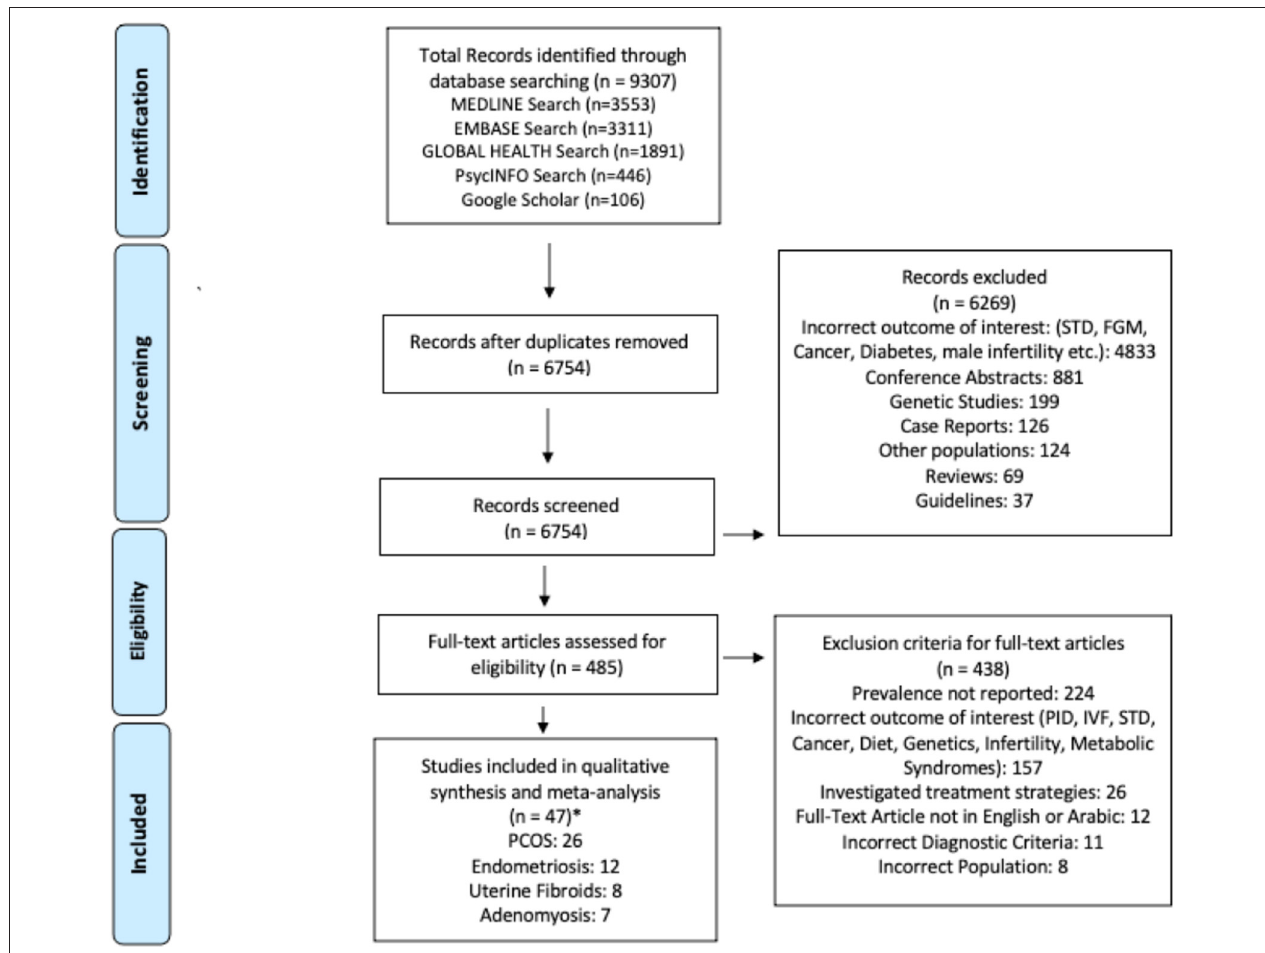
FIGURE 1 | PRISMA Figure. *Six studies reported prevalence estimates for more than one condition.